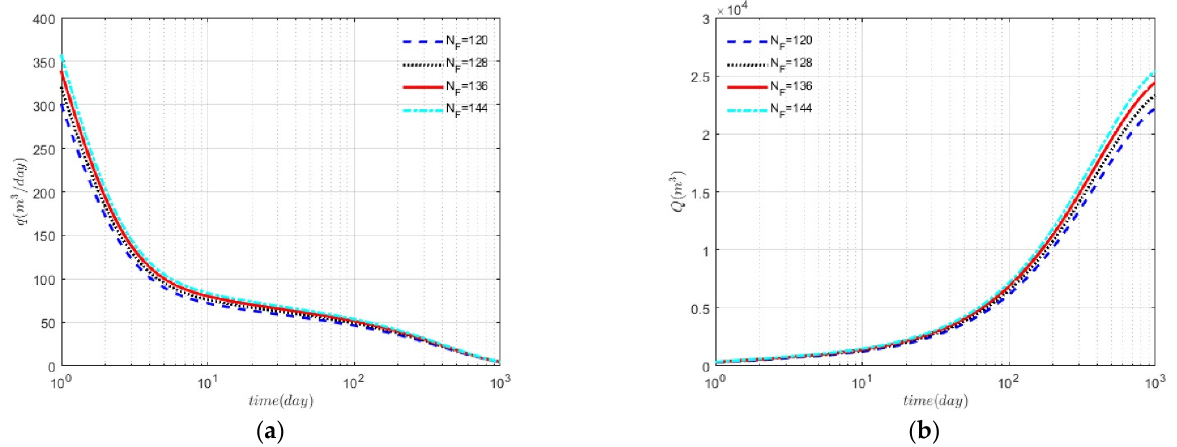
Figure 6. The effect of fracture number on productivity: ( a ) effect of fracture number on well production rate; ( b ) effect of fracture number on cumulative production rate.